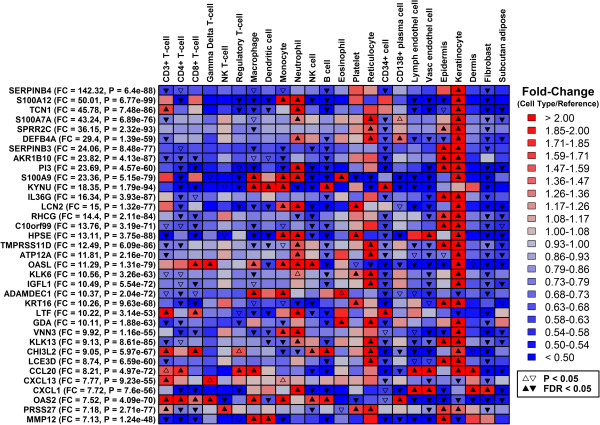
Cell type-specific expression of the 35 genes most strongly elevated in psoriasis lesions (PP) compared to uninvolved skin (PN). The left margin lists the 35 genes most strongly elevated in PP skin relative to PN skin (FDR < 0.05; ranked according to PP/PN fold-change). Heatmap colors show fold-change estimates for each of 24 cell types (columns), with fold-changes estimated as the ratio of a gene’s expression in a given cell type (numerator), relative to its expression among the 23 other cell types (denominator). Triangle symbols denote cases in which gene expression is significantly altered in one cell type as compared to all other cell types (see legend).